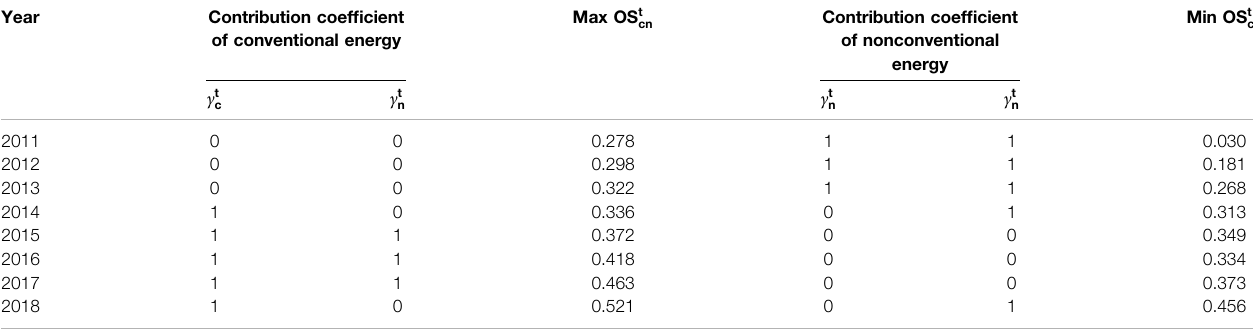
TABLE 8 | Scope of orderliness-synergy degree of the conventional and the nonconventional in 2011 – 2018. Year Contribution coef fi cient of conventional